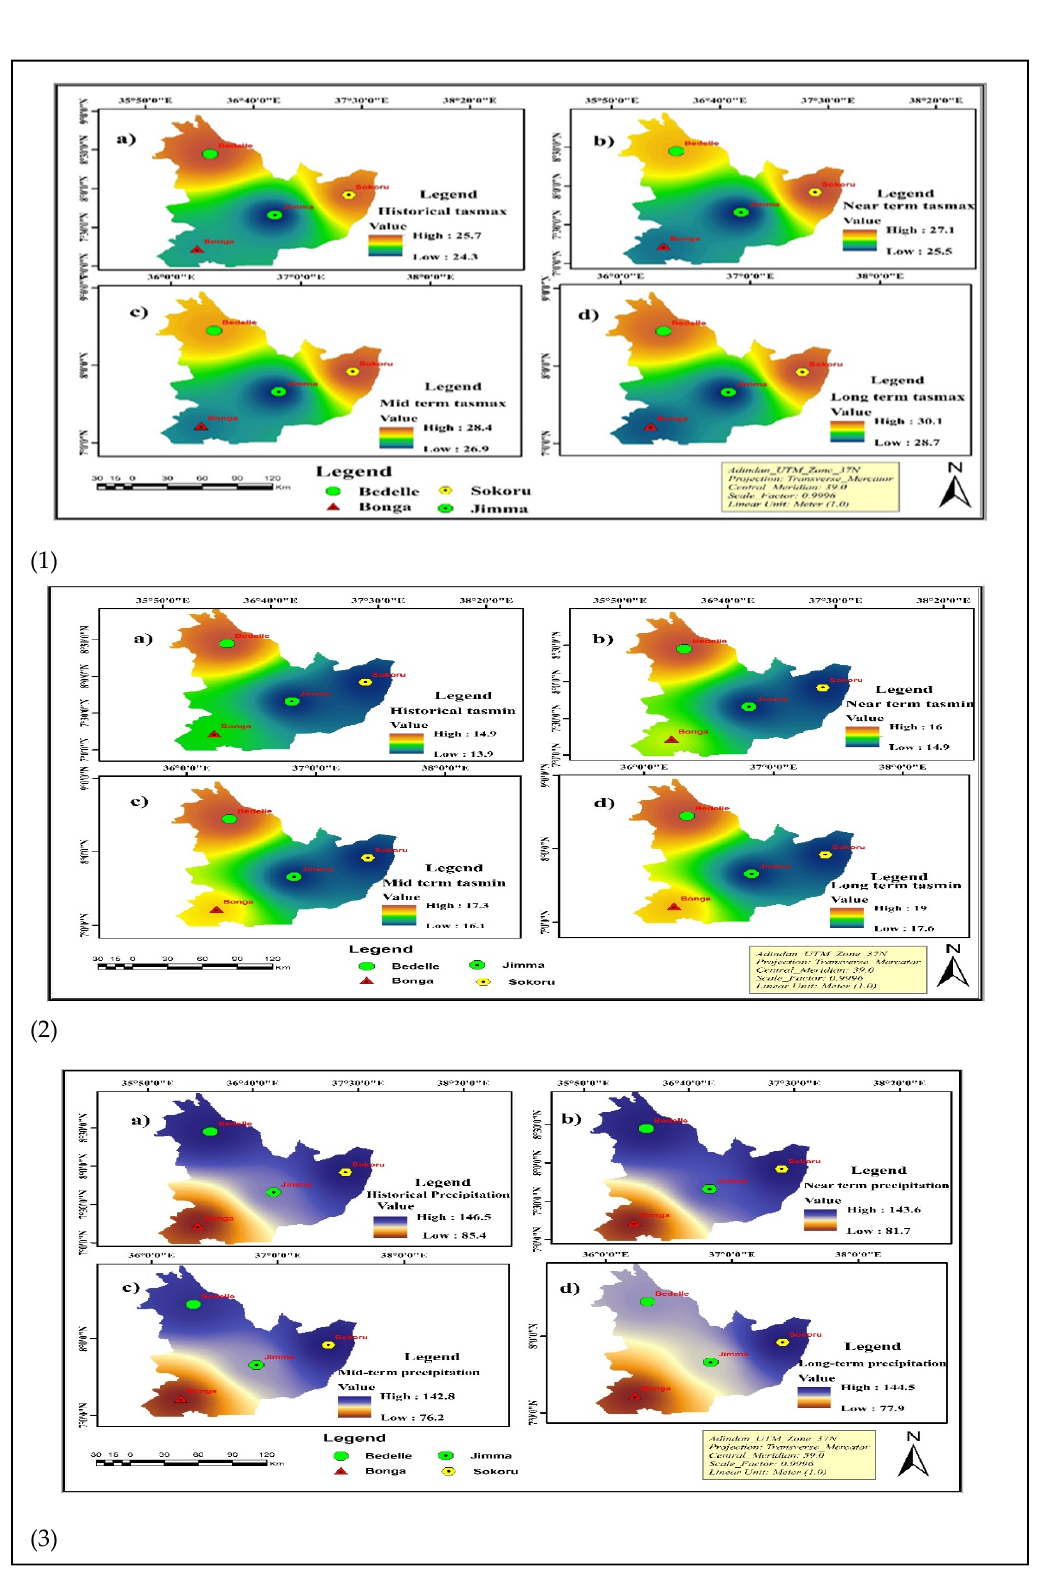
Figure 4. ( Panel 1 ): ( a ) historical, ( b ) near-term (2030), ( c ) mid-term (2050), and ( d ) long-term (2080) maximum temperatures (°C); ( Panel 2 ): ( a ) historical, ( b ) near-term (2030), ( c ) mid-term (2050), and ( d ) long-term (2080) minimum temperatures (°C); and ( Panel 3 ): ( a ) historical, ( b ) near-term (2030), ( c ) mid-term (2050), and ( d ) long-term (2080) monthly mean precipitation (mm/month) for the four stations, as interpolated using Inverse Distance Weighing (IDW) using ArcGIS.